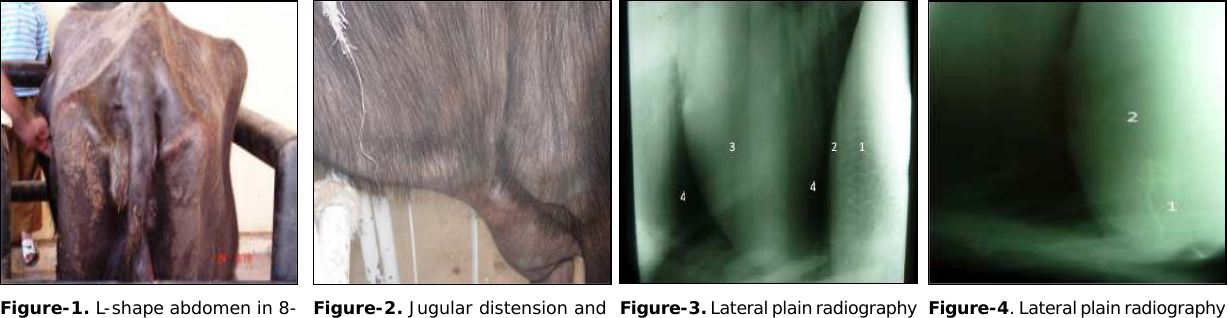
Figure-1. L-shape abdomen in 8- year-old buffalo. The case was diagnosed clinically as “vagus indigestion” and confirmed surgically as “reticular adhesion” at the ventral abdominal wall.